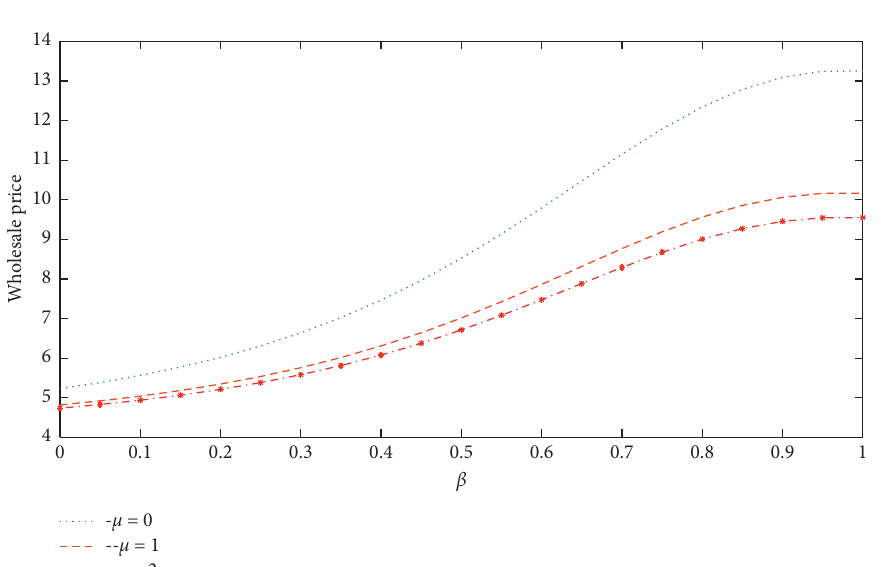
Figure 3: The effect of the cognitive biases on the optimal wholesale